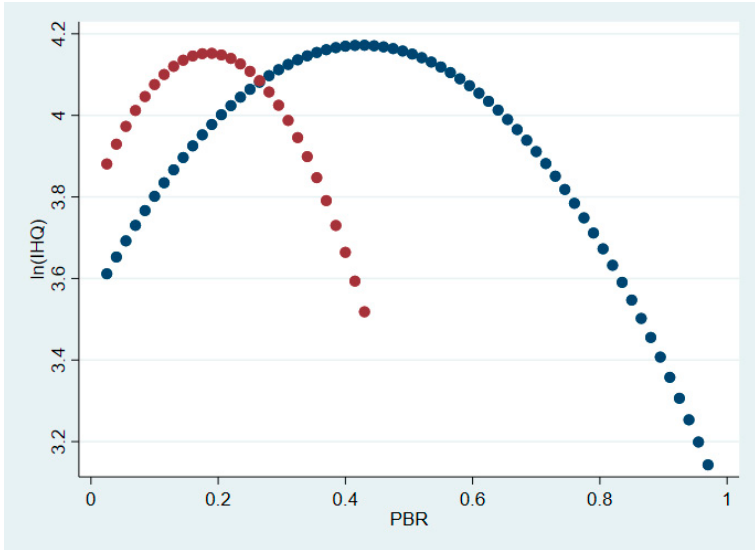
Figure 2. Predicted values of ln( IHQ ) as a function of PBR for different values of research impact. The blue dots represent the predicted values of ln( IHQ ) as a function of PBR where the H-index is held at its modal value (0.5). The red dots represent the predicted values of ln( IHQ ) as a function of PBR where the H-index is held at its second most frequent value (2.5).